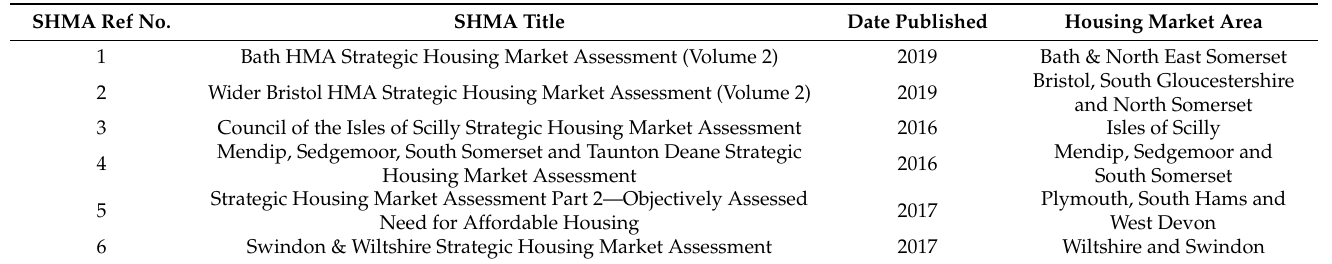
Table 6. Strategic Housing Market Assessments (SHMAs) published in the study area post 2015. SHMA Ref